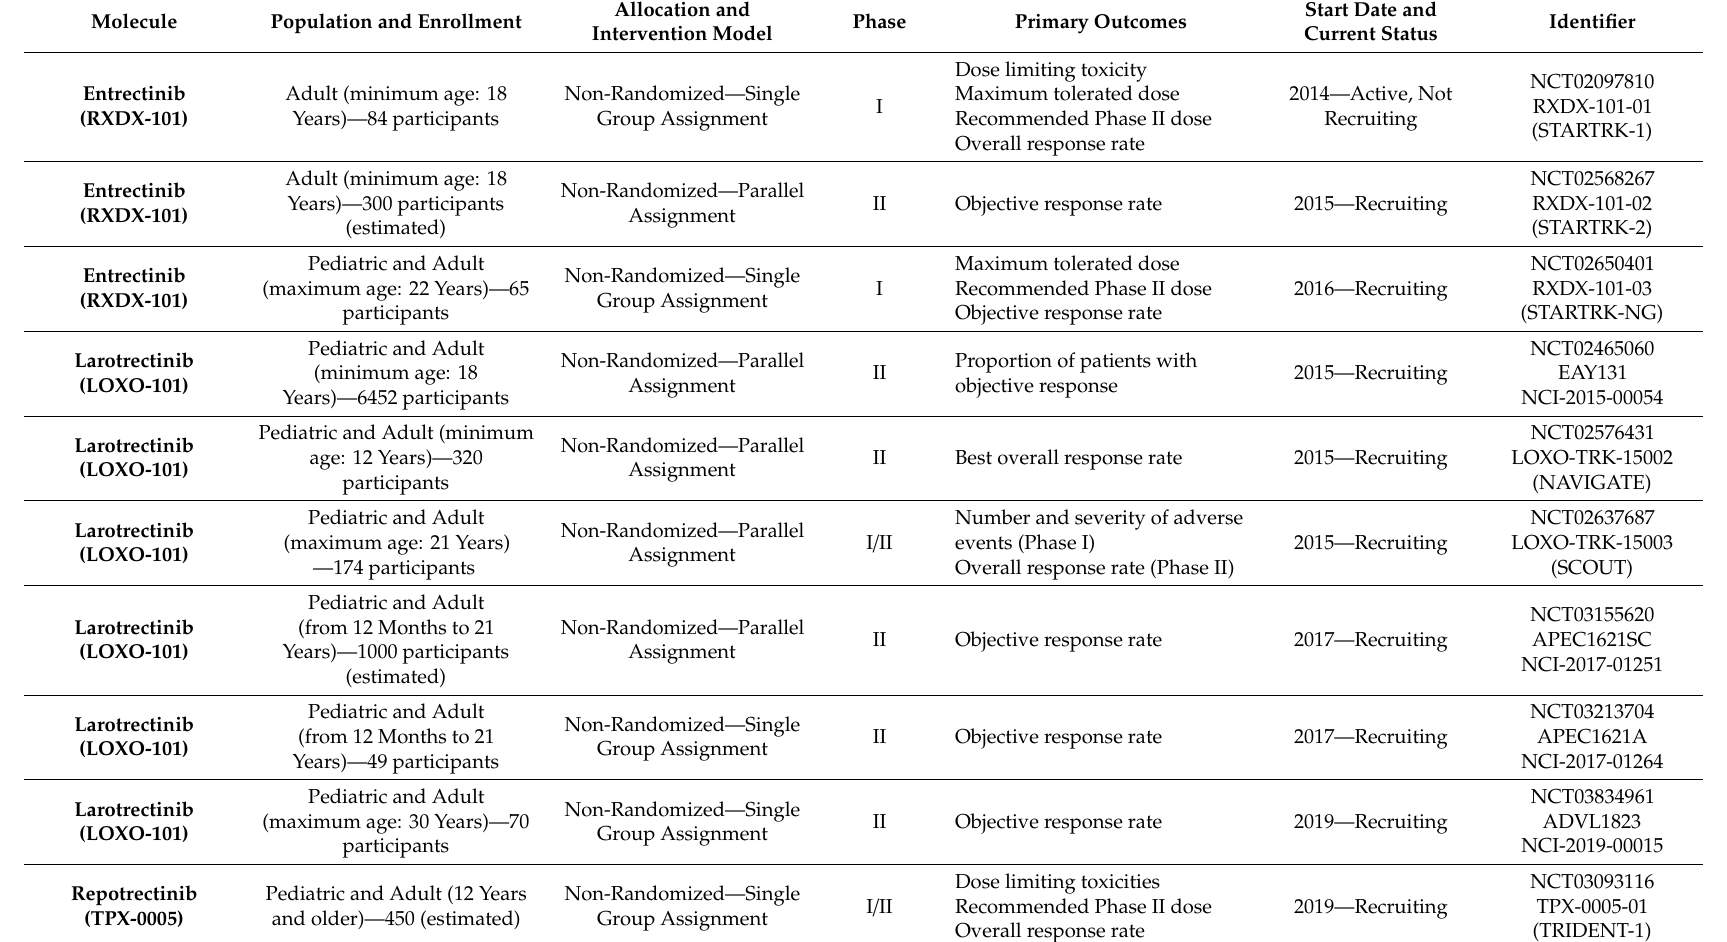
Table 2. Main clinical trials evaluating NTRK -fusion